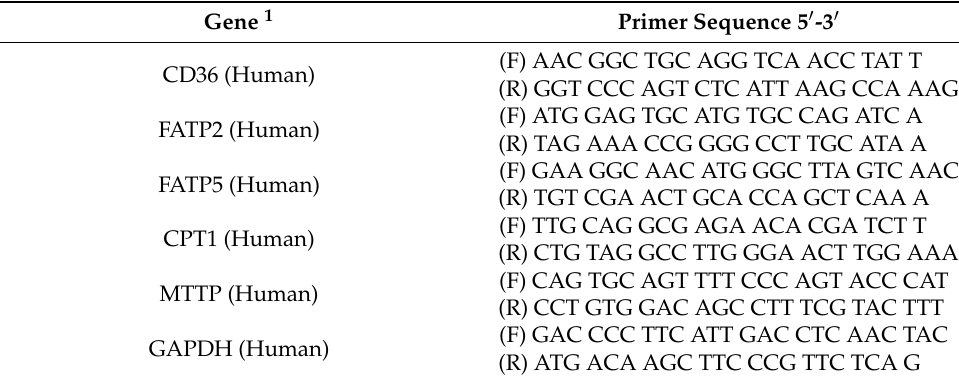
Table 1. Primers used for RT-PCR